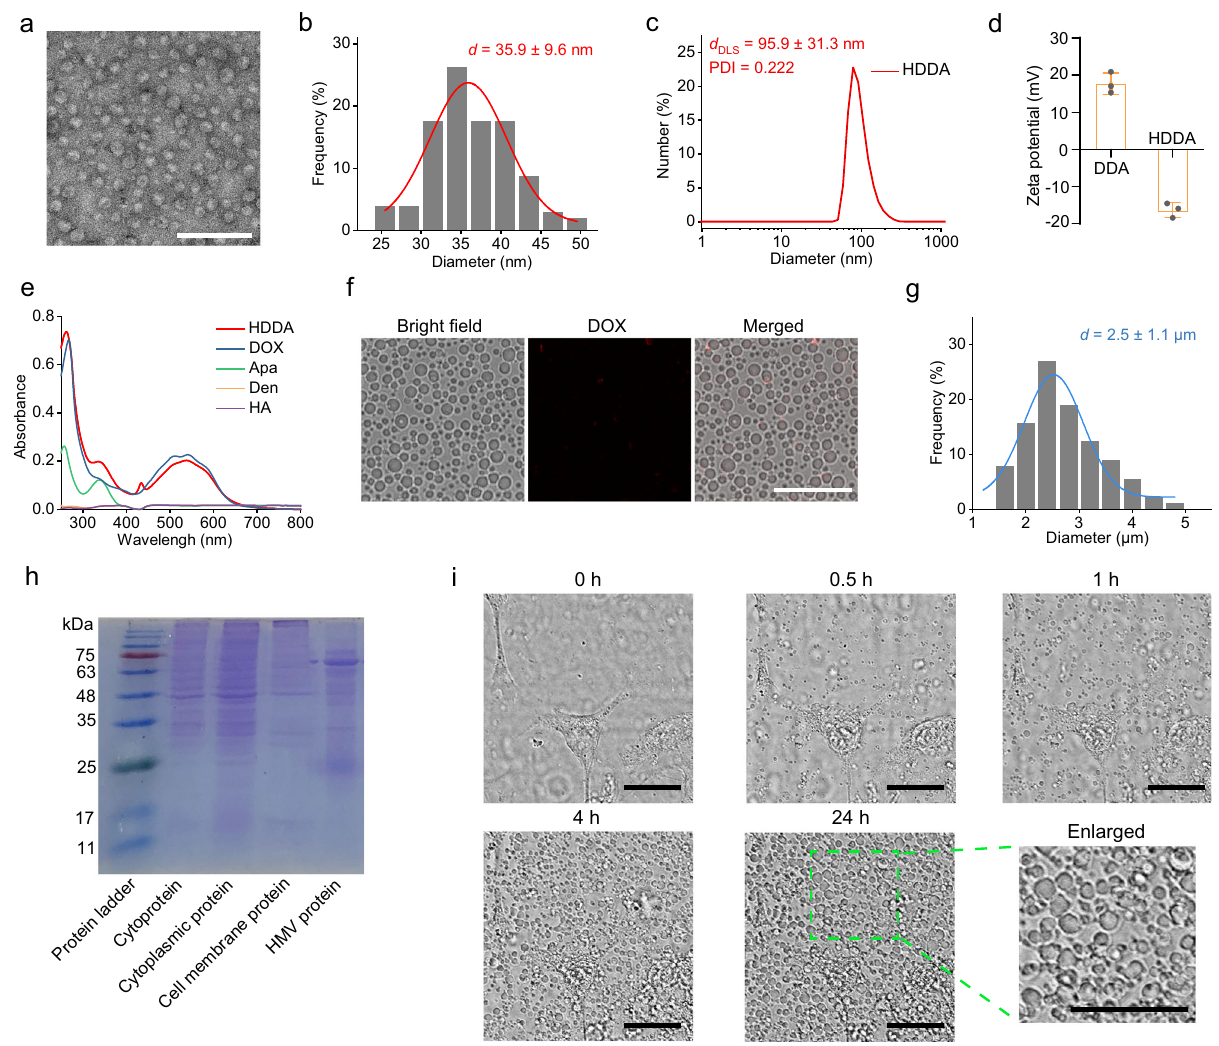
Fig. 2 | Preparation, characterization, and HMV production of HDDA NBs. a TEM image and b corresponding size distribution histogram of HDDA NBs. Scale bar: 300nm. c Hydrodynamic diameter result of HDDA NBs. d Zeta potentials of DDA and HDDA. Data are presented as mean±standard deviation (SD). n =3 samples per group. e Ultraviolet – visible (UV – vis) absorption spectra of the solutions or suspensions containing HA, Den, Apa, DOX, or HDDA. f Confocal microscopic images and g corresponding size distribution histogram of HDDA- treated (for 24 h) 4T1 cells. Scale bar: 30 μ m. h SDS-PAGE results of